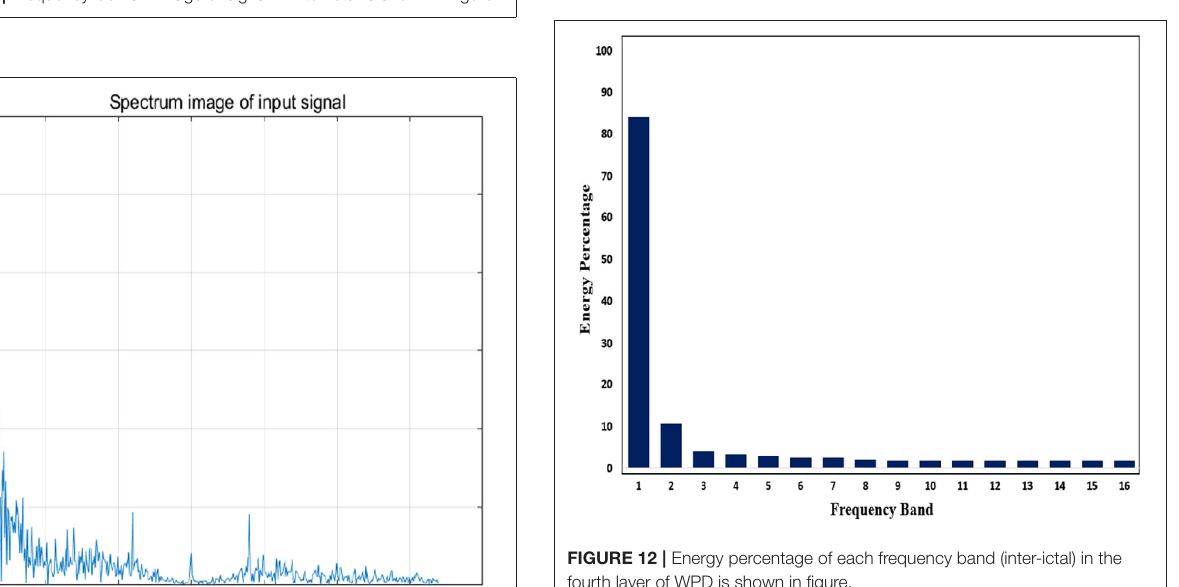
be seen from the former that times of high frequency increases significantly in pre-ictal period.